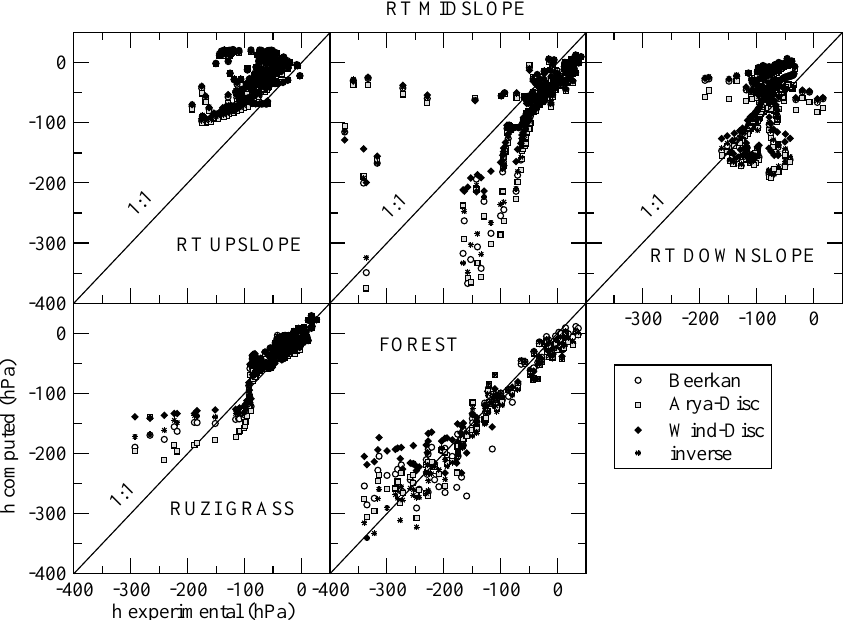
Figure 5. Scatterplots of computed vs. experimental matric potential values in the different locations for different combinations of